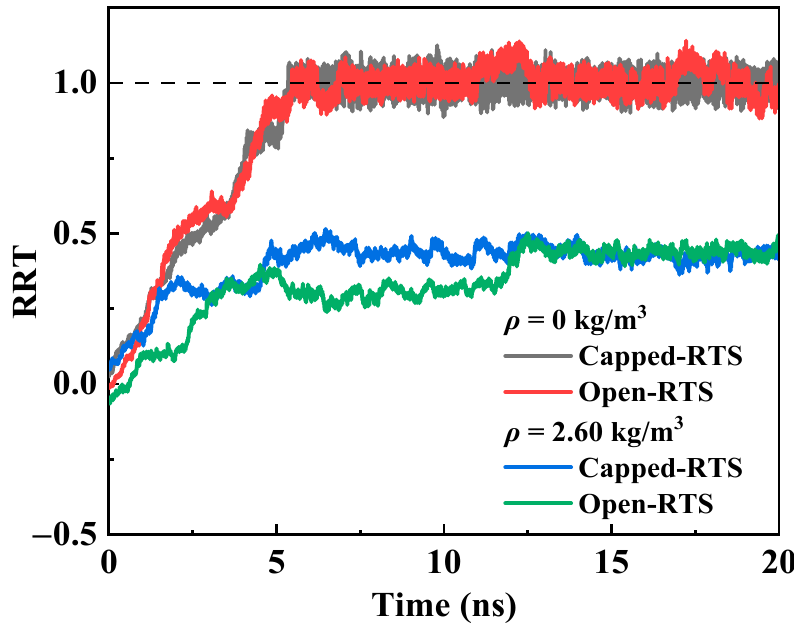
Figure 1. Time histories of RRT curves for the two RTS models with different rotor end structures in vacuum and helium environments.